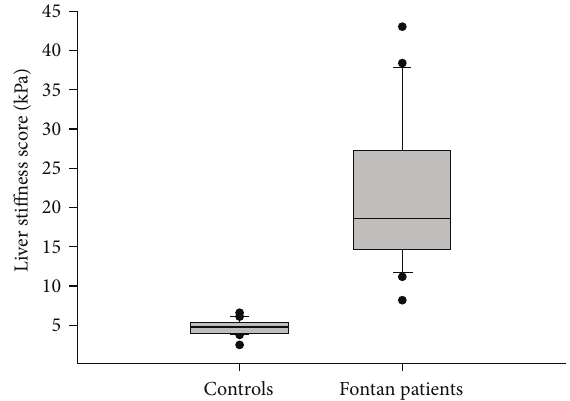
Figure 1: Box plots representing transient elastography results by study cohort. The 10th, 25th, 50th, 75th, and 90th percentiles are reported. Outliers are represented by ∙ .